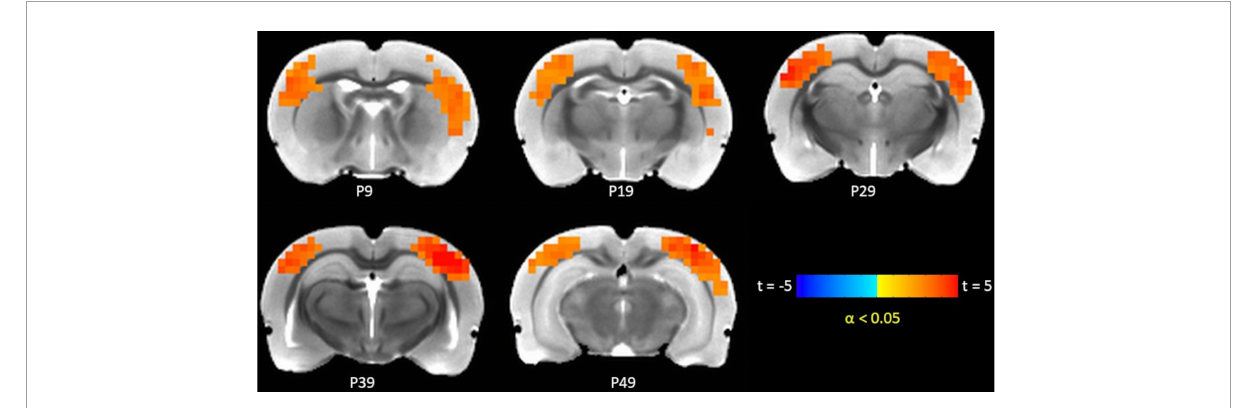
FIGURE3 TTA-P2 vs. Baseline t -statistic maps highlighting regions with enhanced functional connectivity (FC) to right S1BF ROI after TTA-P2 administration. The slice-location coordinates are in Paxinos space. Left hemisphere is on the left-hand side of the maps.